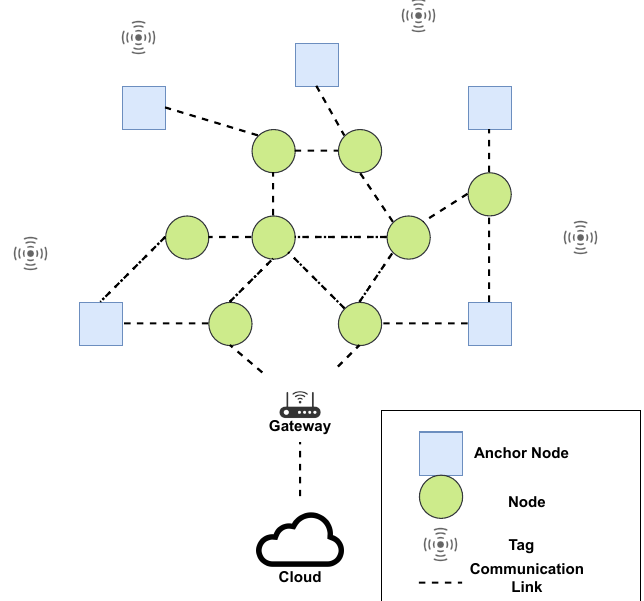
Figure 1. An IoT mesh network with a DOA-based positioning